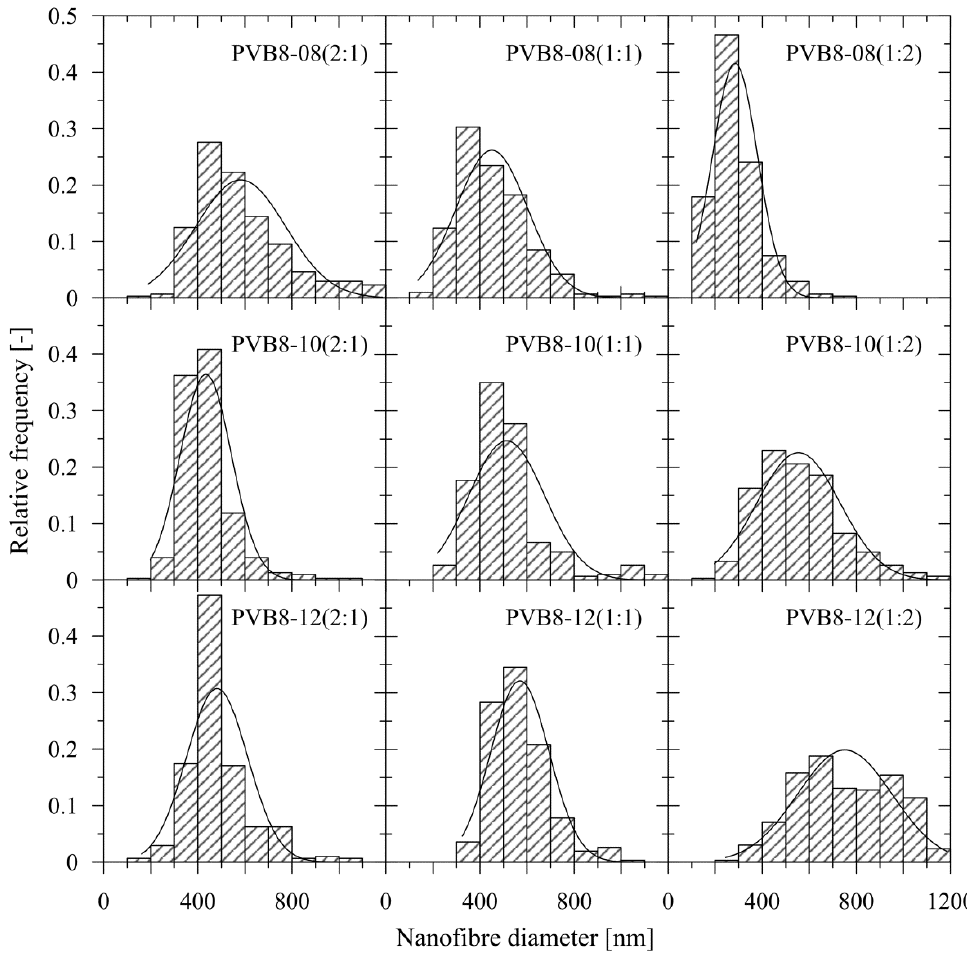
Figure 7. Mean nanofiber diameters for recycled, blended and virgin PVB.